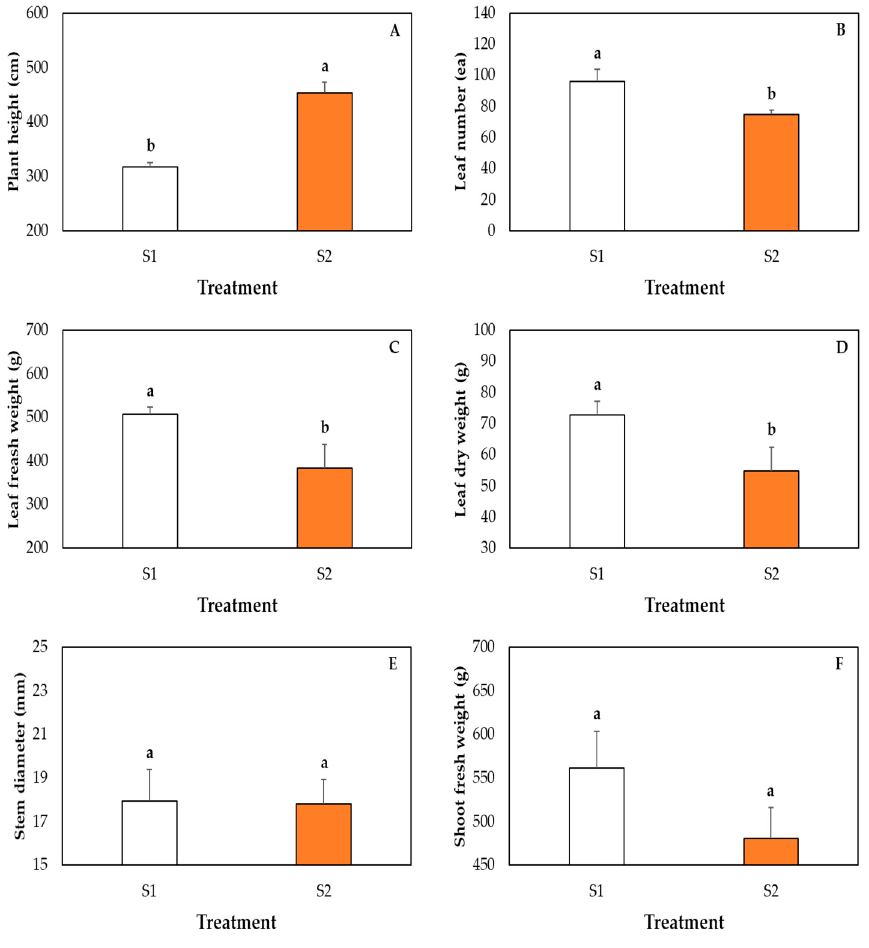
Figure 6. Effect of shade screen on plant height ( A ), leaf number ( B ), leaf fresh weight ( C ), leaf dry weight ( D ), stem diameter ( E ) and shoot fresh weight ( F ) of paprika in greenhouse. S1 and S2 indicate that plants were treated by single shade screen and double shade screens, respectively. Lines above bar represent the standard deviation of the mean ( n = 10). Means above each bar followed by the same letters are not significantly different by Duncan’s multiple range test (DMRT) at p ≤ 0.05.